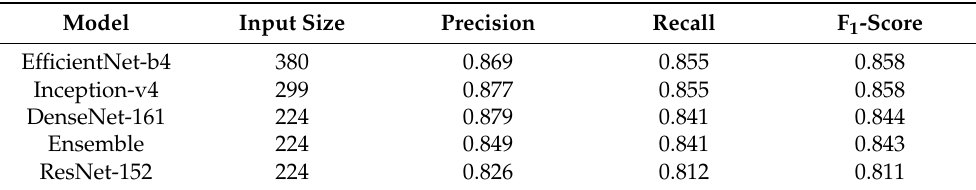
the best model checkpoints. Precision, recall, and F 1 -score are reported as weighted macro-averages. averages.